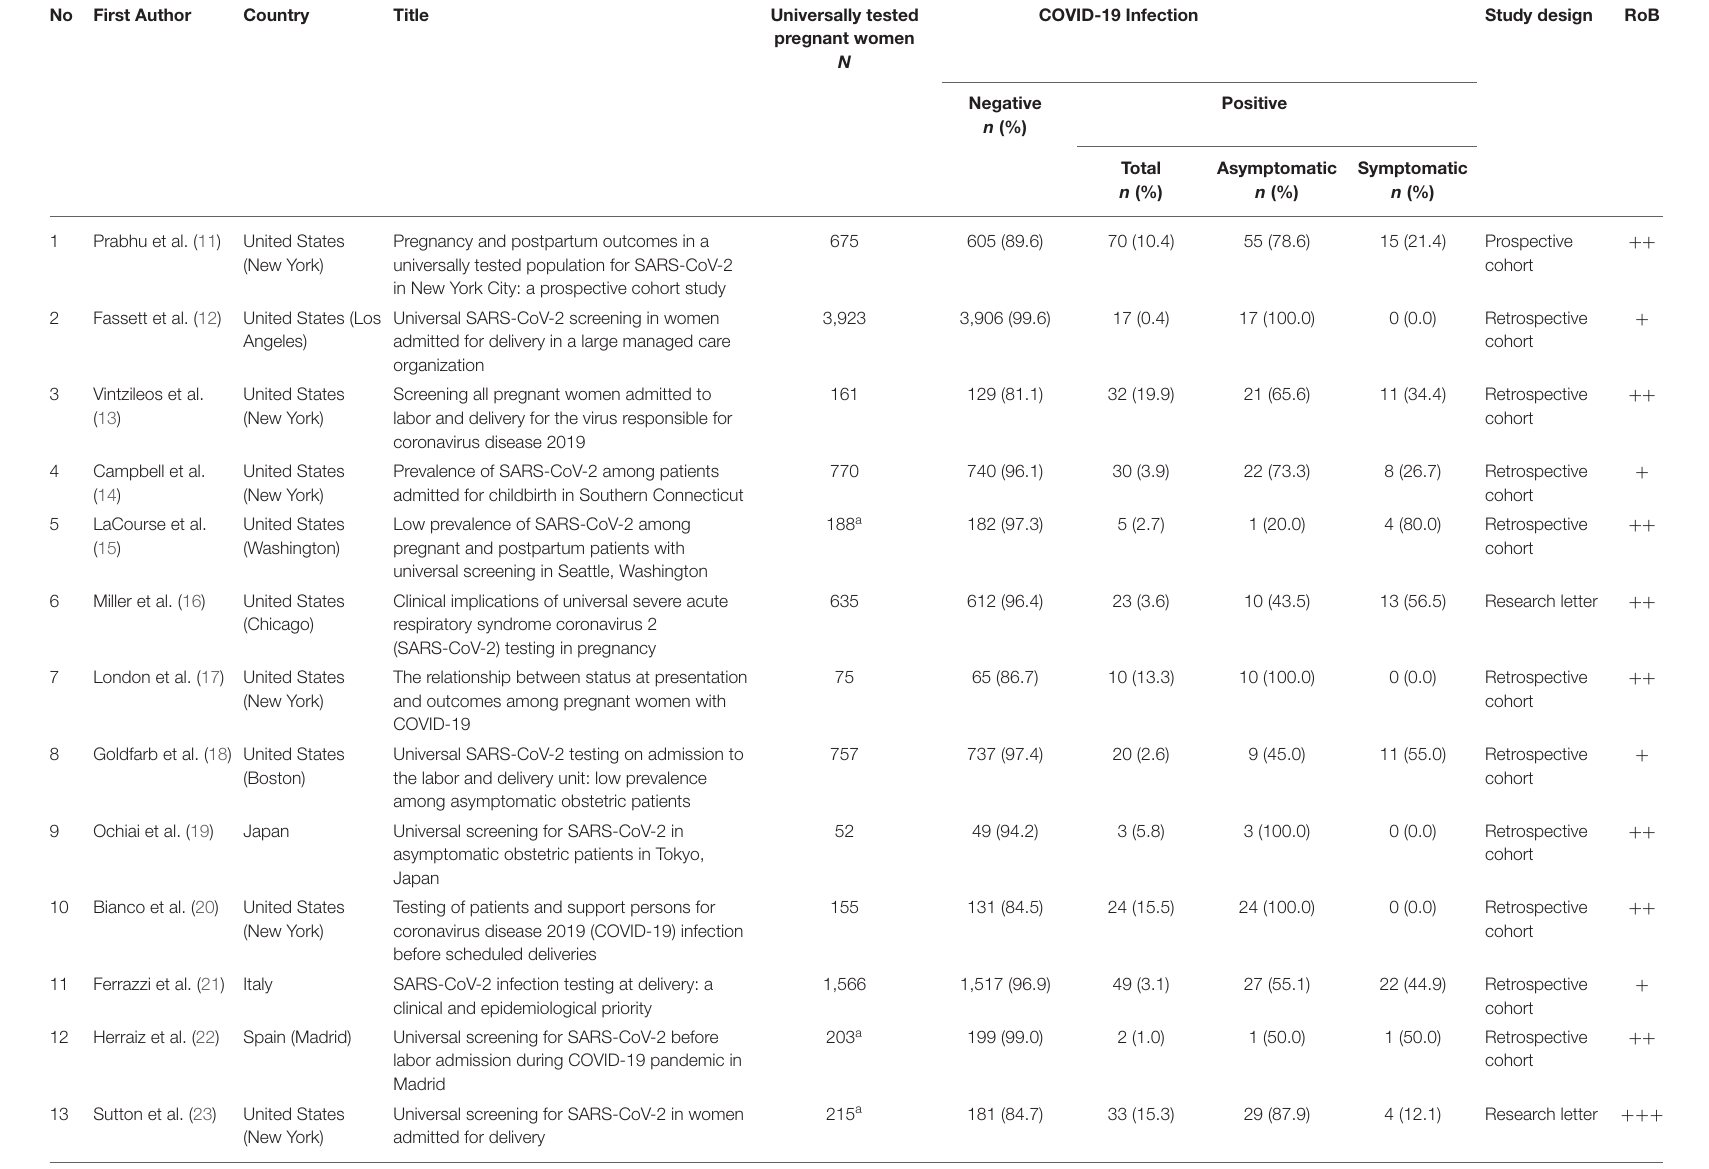
TABLE 2 | Summary of studies reviewing the outcome of universal testing and the prevalence of asymptomatic pregnant women with positive